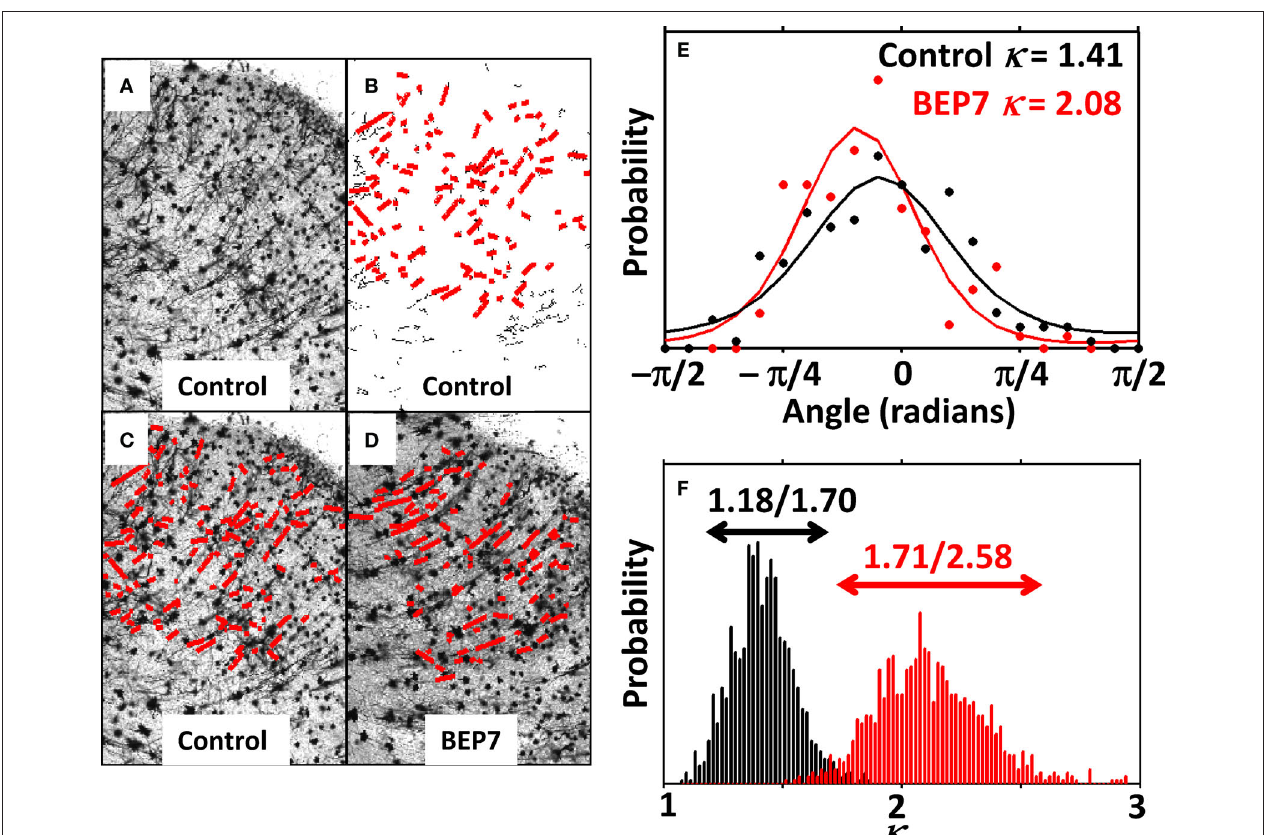
representing the distribution of polar angles are shown for the Cntrl-1 (black data points) and BEP7-1 (red data points) Golgi fields. Solid lines in (e) represent the results of approximating the data points as a von Mises distribution. To estimate 95% confidence intervals κ , a bootstrap procedure was used in which κ was determined 1000 times from randomly sampled subsets of the measured polar angles for each field. Histograms, with associated 95% confidence regions, of the resulting κ values are shown in (F) for the set of angles derived from Cntrl-1 (black) and BEP7-1